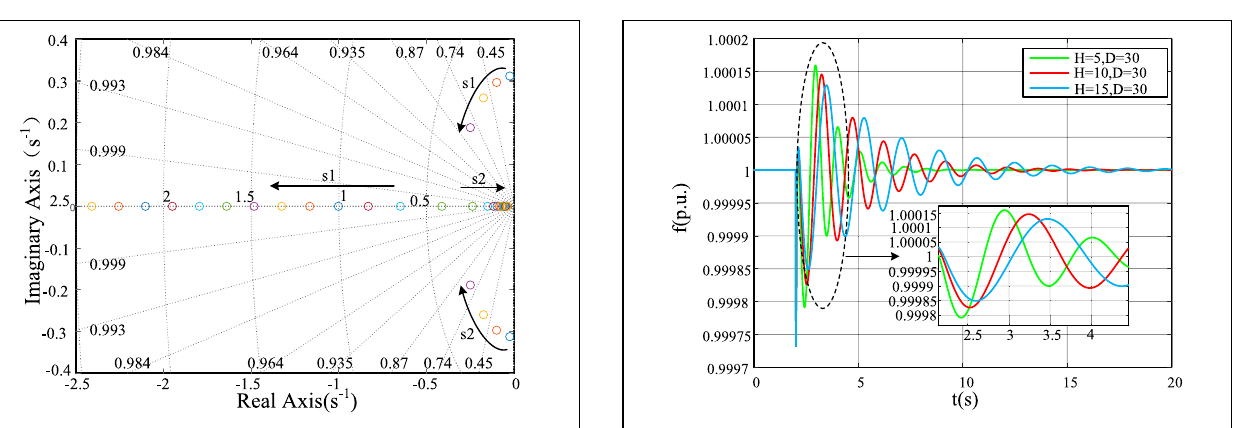
FIGURE 9 | Trajectories of characteristic roots for D from 1 to 50 at H = 30. FIGURE 10 | Frequency of the grid-connected inverter when virtual inertia time constant changes.